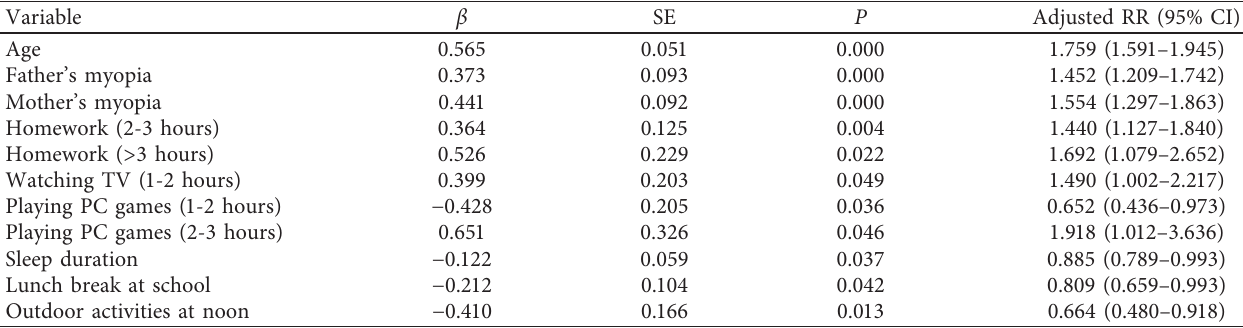
Table 2: G × E interaction factors of myopia for Chinese children.